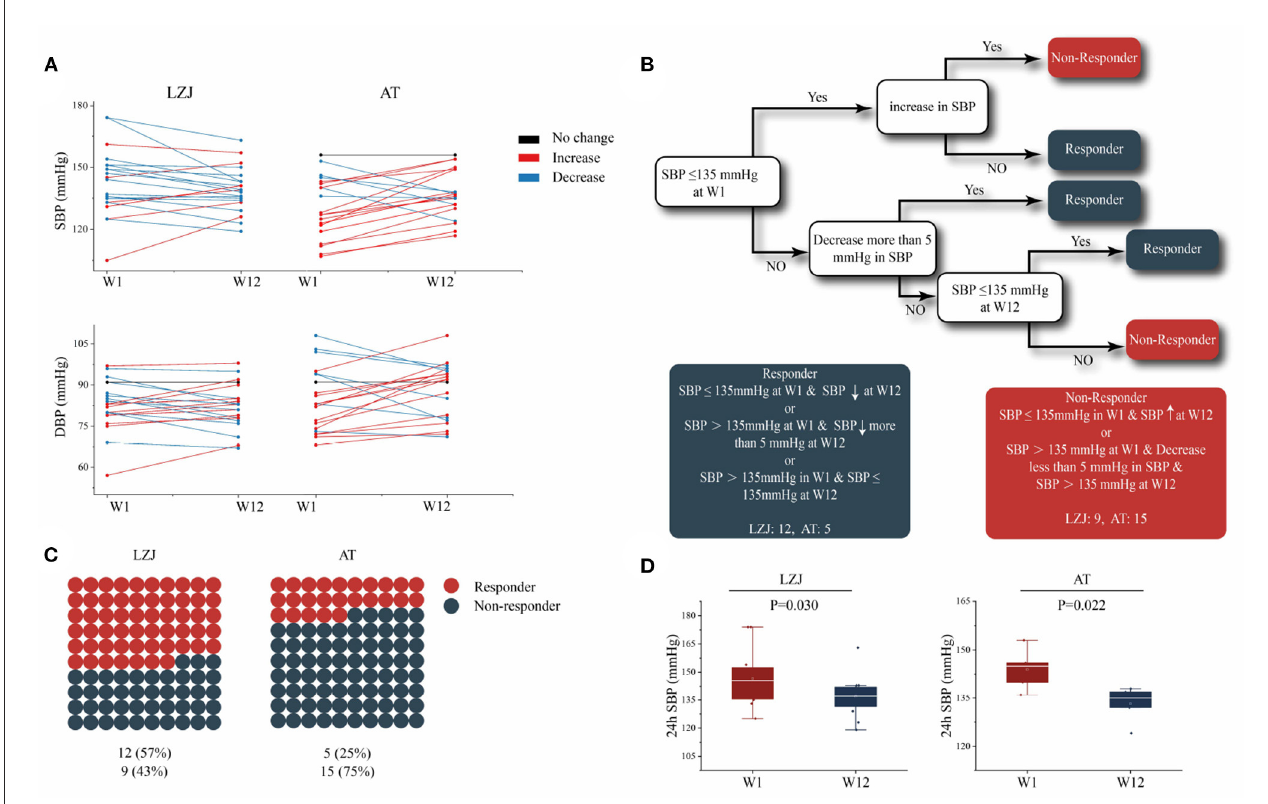
FIGURE3 The effect of AT and LZJ exercises on hypertensive. (A) Lines show individual participant trajectories at the 24 h SBP. (B) Decision tree for the determination of BP responders and BP non-responders. According to the changes of 24 h-SBP in individuals before and after intervention (W1–W12), hypertensive patients were divided into BP responders and BP non-responders. BP responders: (i) SBP was lower or equal to 135 mmHg at W1, and decreased at W12; (ii) SBP is higher than 135 mmHg at W1 and decreases more than 5 mmHg at W12; (iii) SBP is higher than 135 mmHg at W1 but lower than or equal to 135 mmHg at W12. BP non-responders: (i) SBP is lower than or equal to 135 mmHg at W1, but SBP rises at W12; (ii) SBP is higher than 135 mmHg at W1, SBP decrease is not more than 5 mmHg and SBP is still higher than 135 mmHg at W12; (C) The proportion of BP responders in LZJ and AT groups, with red circles representing the BP responder and blue representing the non-BP responder; (D) The change of 24 h SBP in BP responders; The line within the boxplot indicates the median. Whiskers are drawn to minimum and maximum values, but not further than 1.5 ×